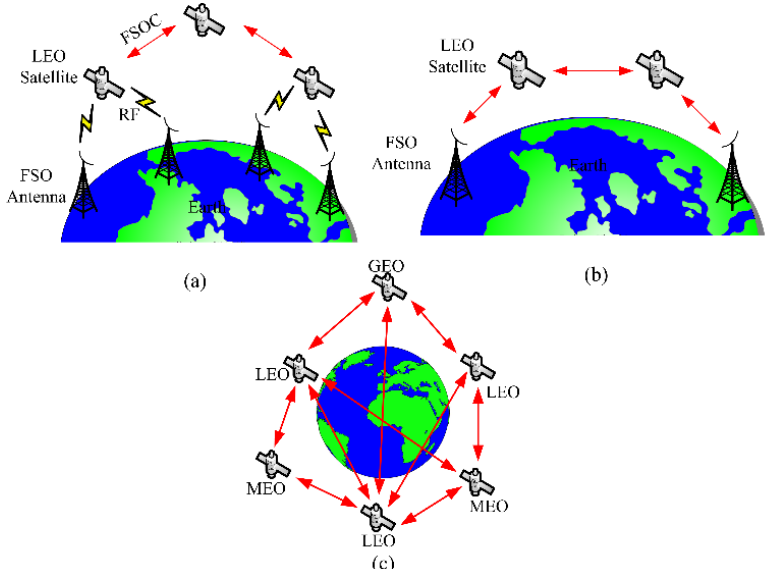
Figure 27. Different installation scenarios of satellite FSOC networks: ( a ) RF and FSOC link; ( b ) direct satellite FSOC link; and ( c ) global satellite FSOC link.